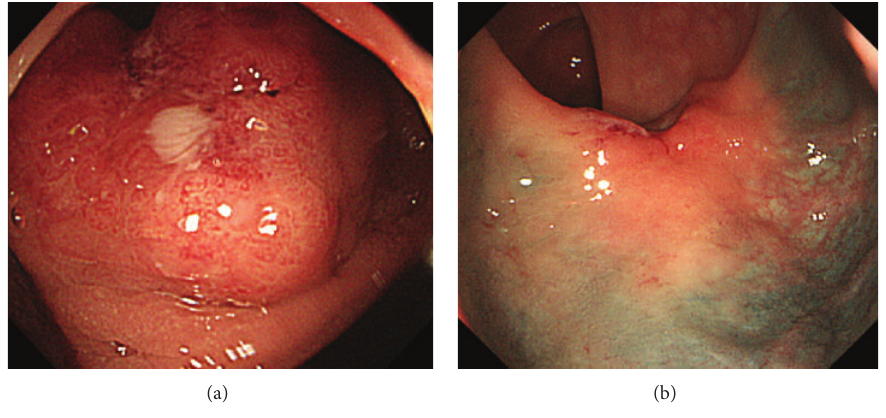
Figure 1: Colonoscopy before (a) and after (b) chemoradiotherapy (CRT).